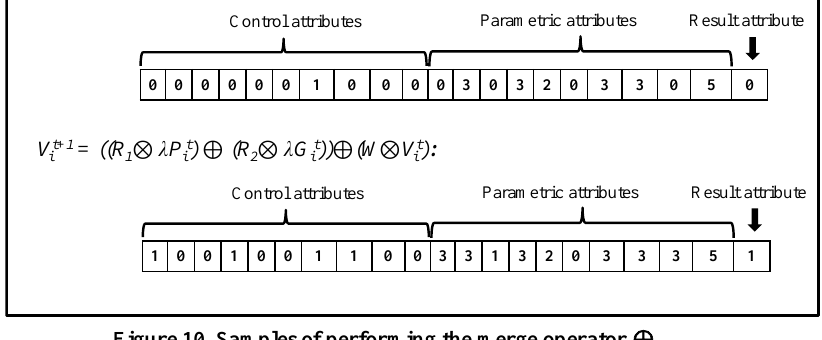
Figure 10. Samples of performing the merge operator ⊕.